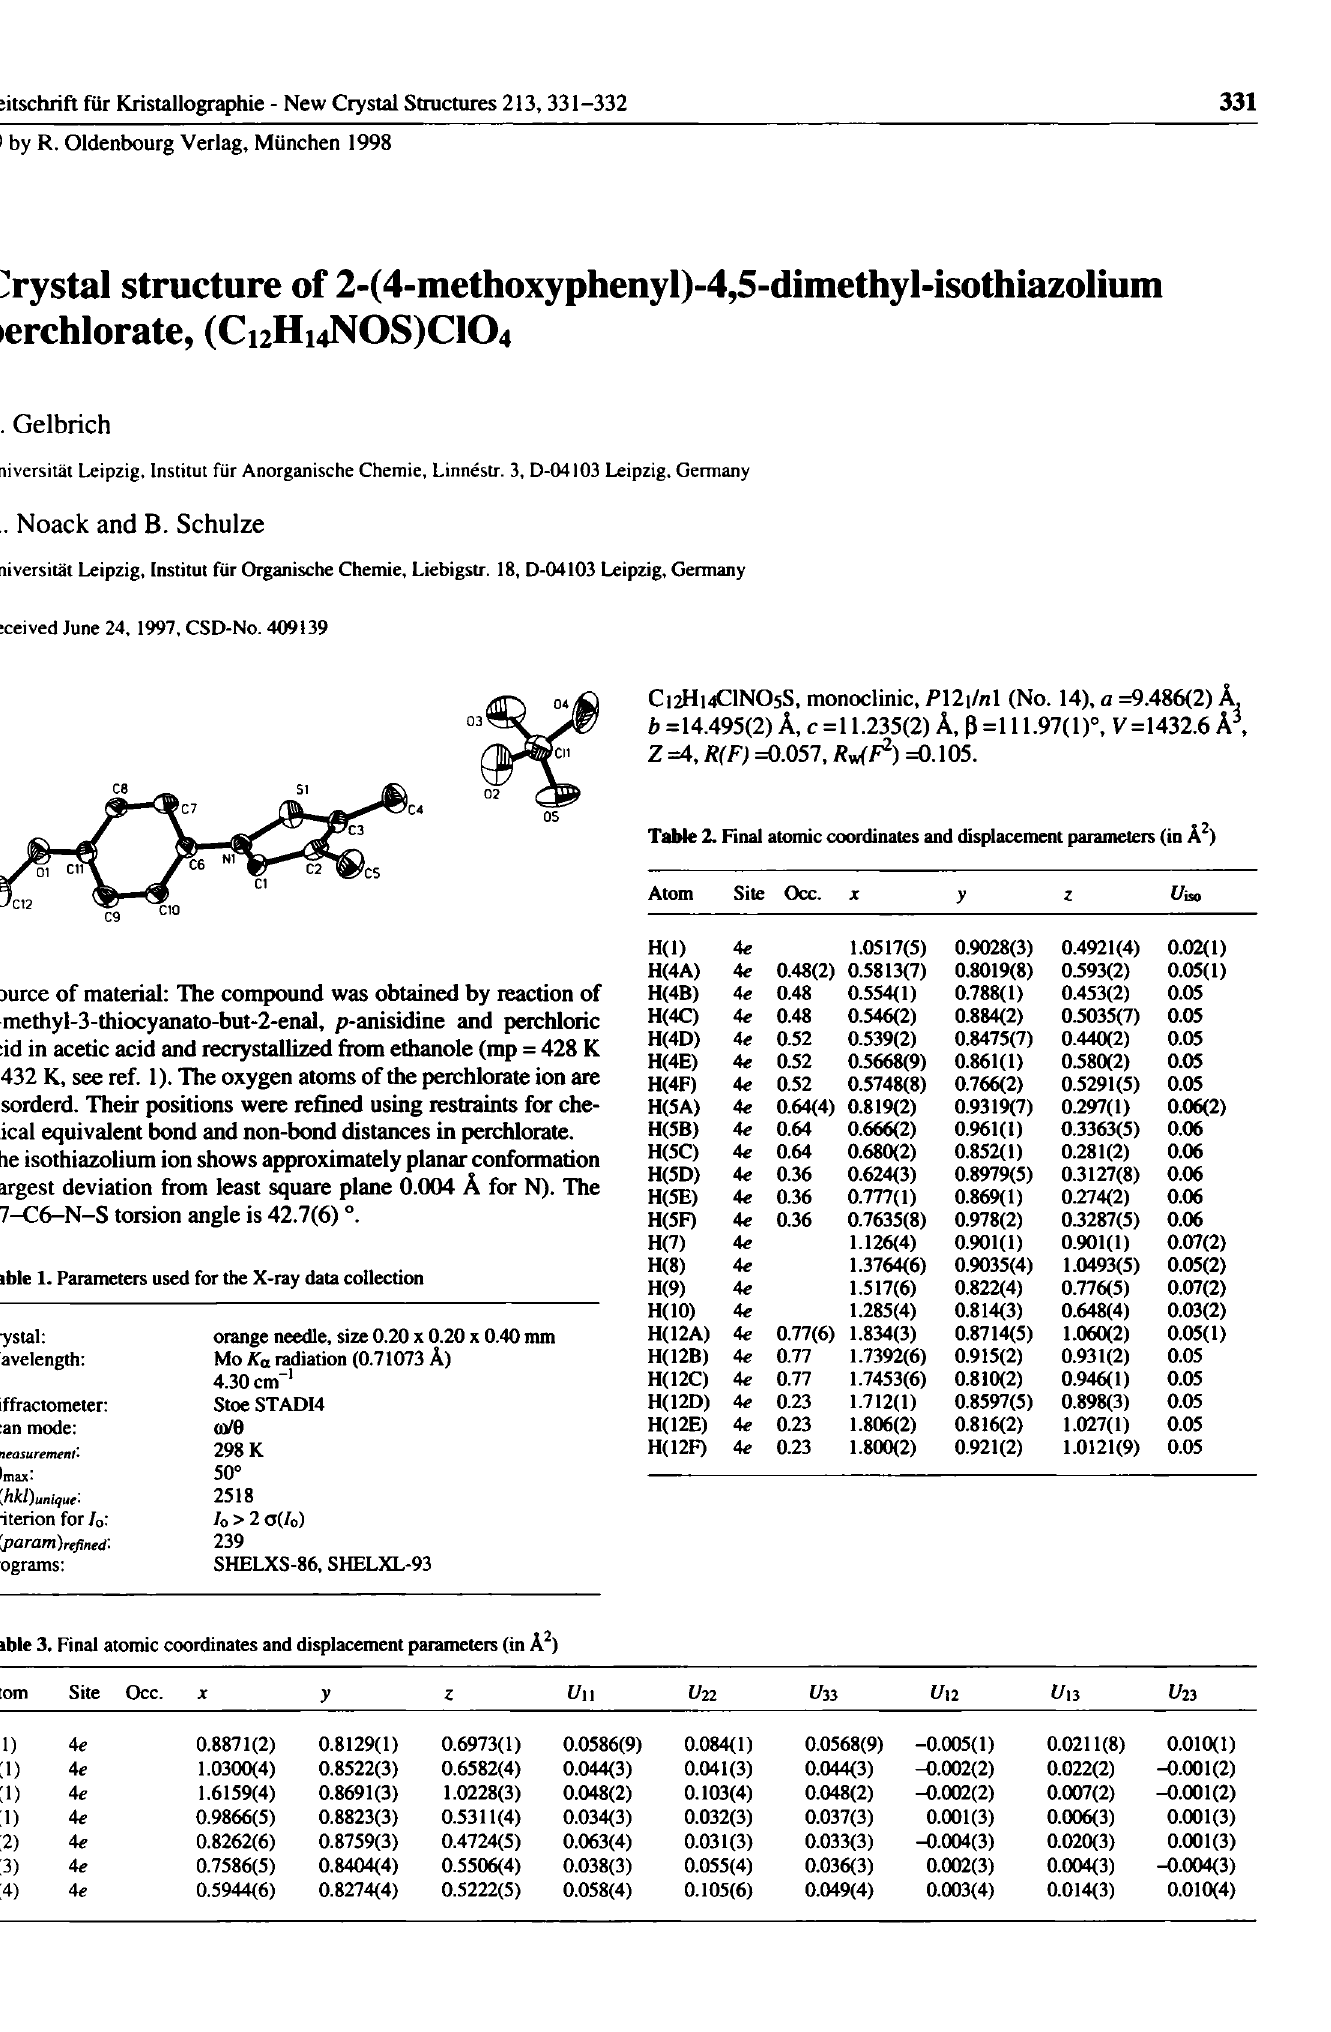
Table 3. Final atomic coordinates and displacement parameters (in Â^)